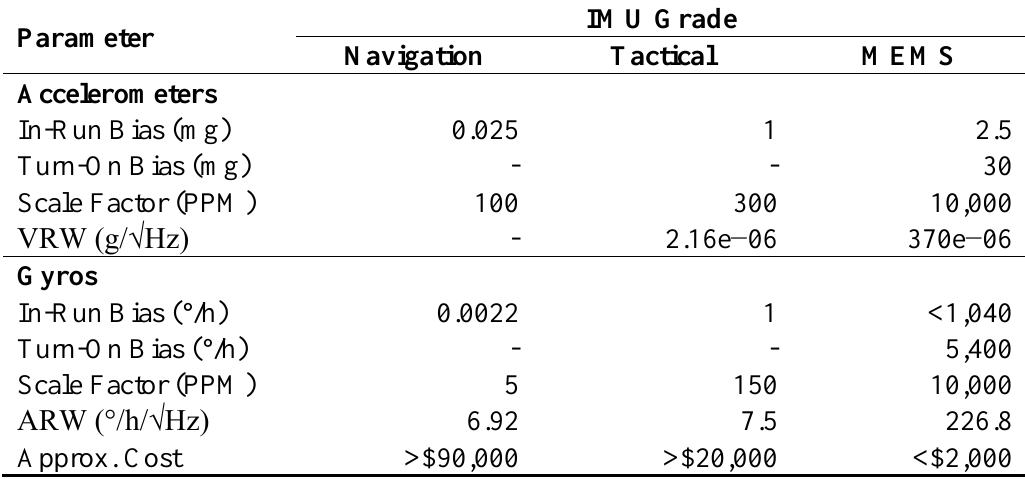
Table 1. Summary of IMU characteristics for different grades of sensors (from